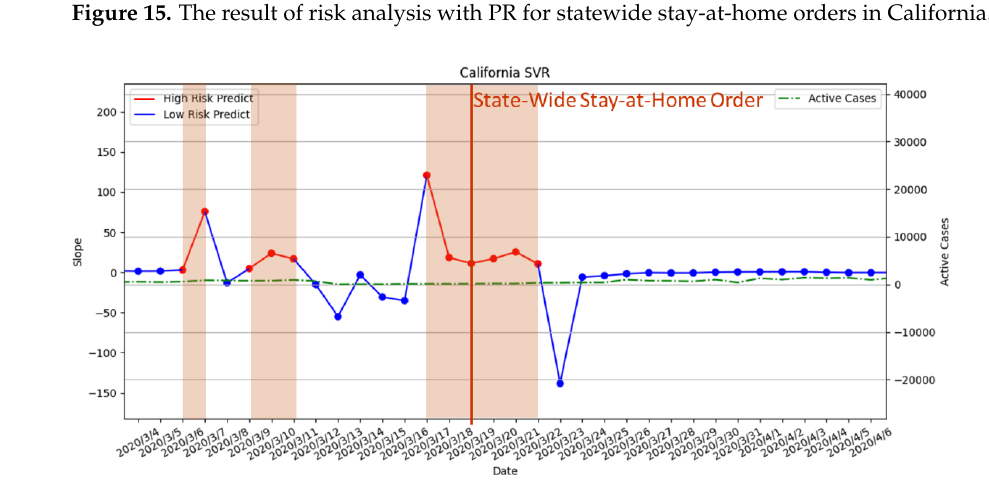
Figure 16. The result of risk analysis with SVR for statewide stay-at-home orders in